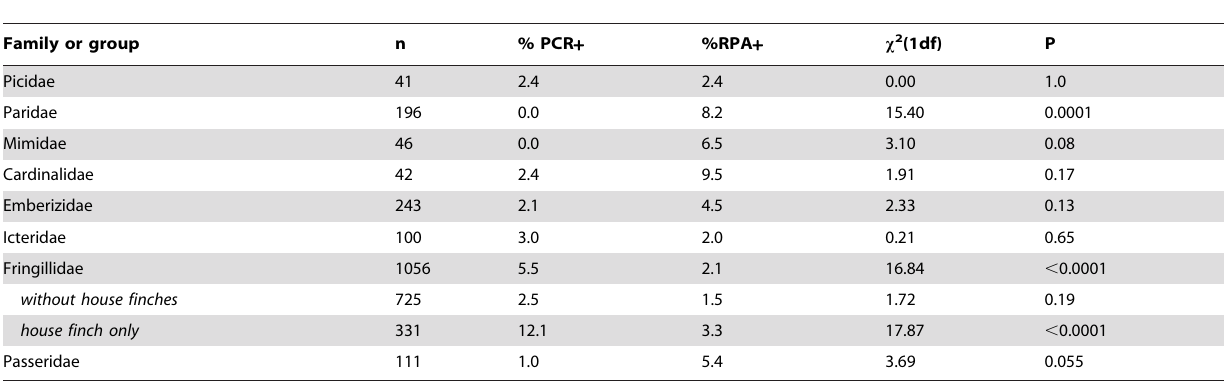
Table 2. Percentages of individuals trapped in Tompkins County that tested positive for M. gallisepticum.